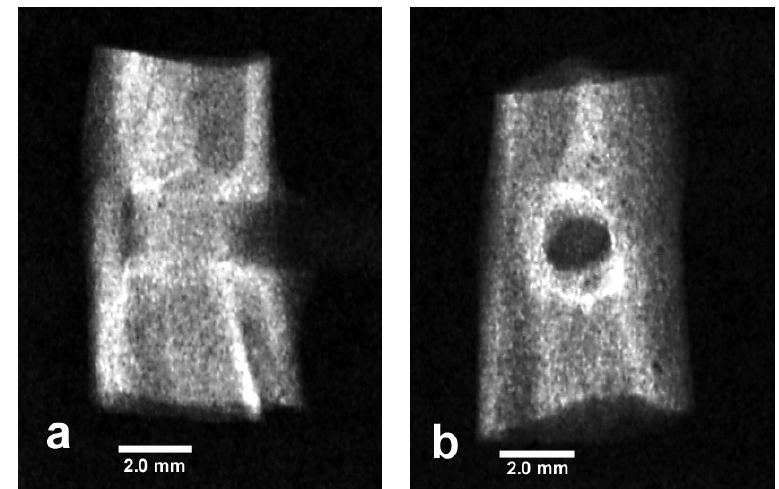
Figure 6. X-rays epoxy/carbon fiber PMC ( a ) Lateral view ( b ) Frontal